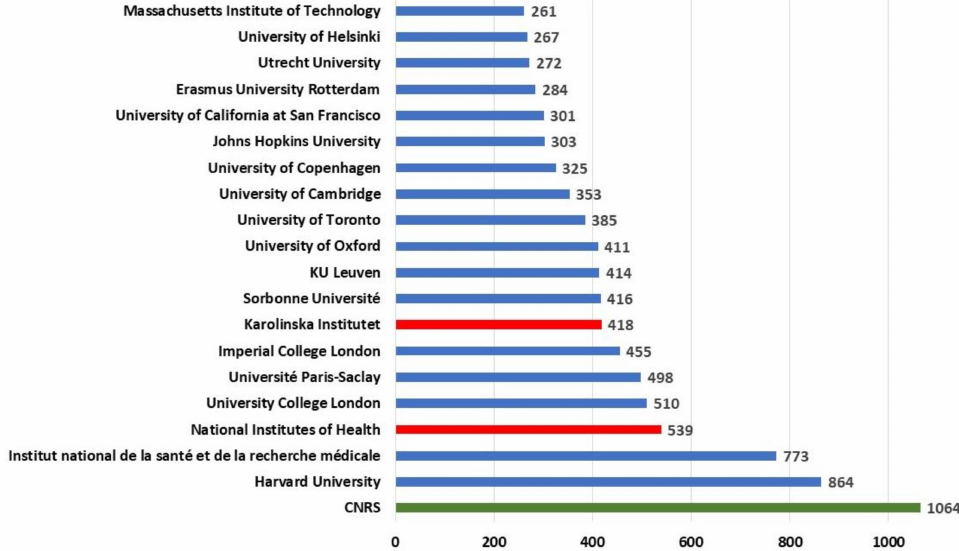
Figure 5. Top 20 Foreign institutions that collaborates with Spanish